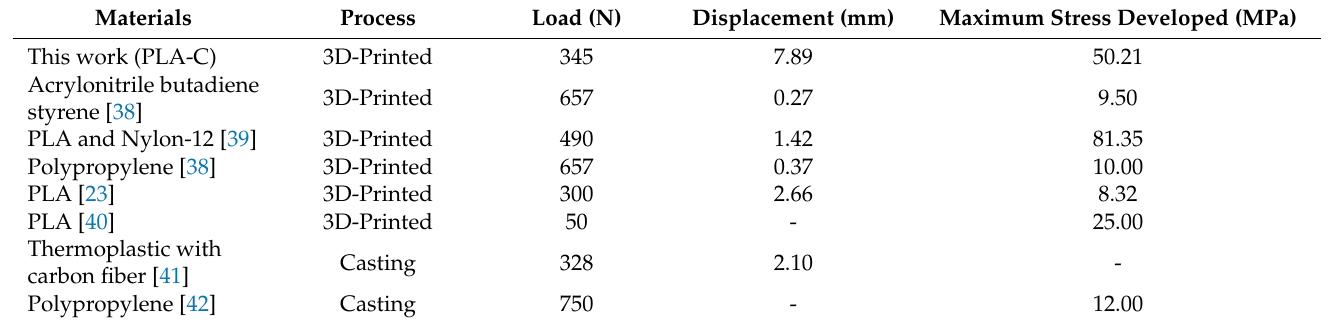
Table 6. Comparative study between the present work and previously published articles on